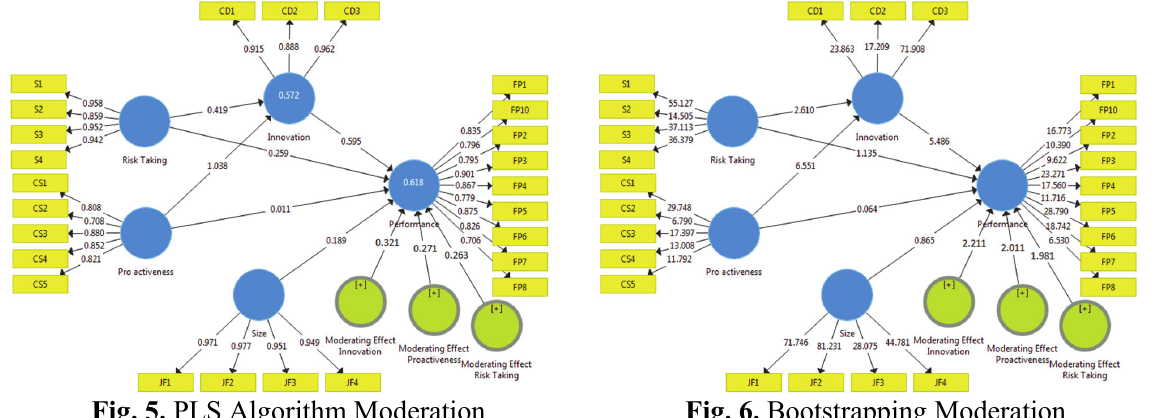
Fig. 5. PLS Algorithm Moderation Fig. 6. Bootstrapping